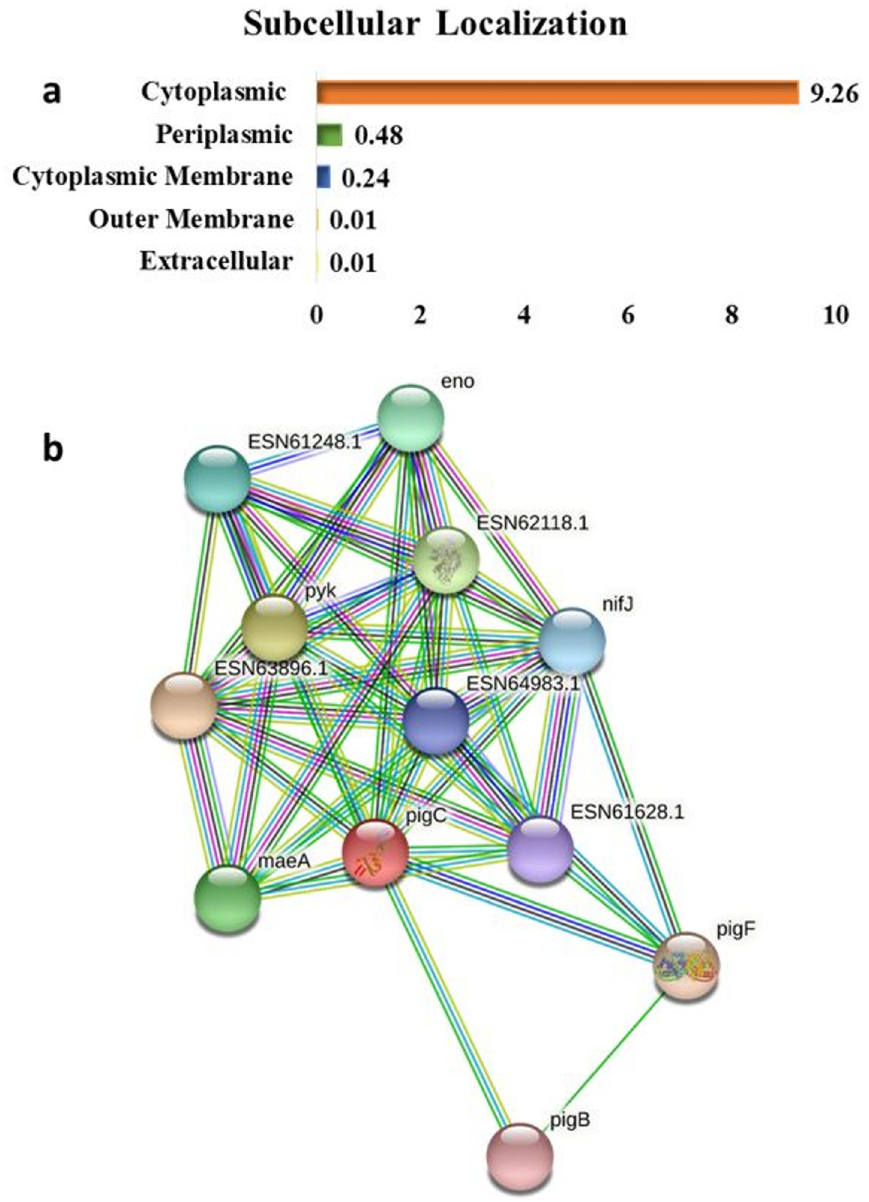
Fig 4. Functional characterization of protein. (a) The sub-cellular localization of protein. The results are indicating that the query protein belongs to cytoplasmic region in the cell. (b) Image showing the network topology of the query protein in red color (PigC) generated by STRING database showing the top 11